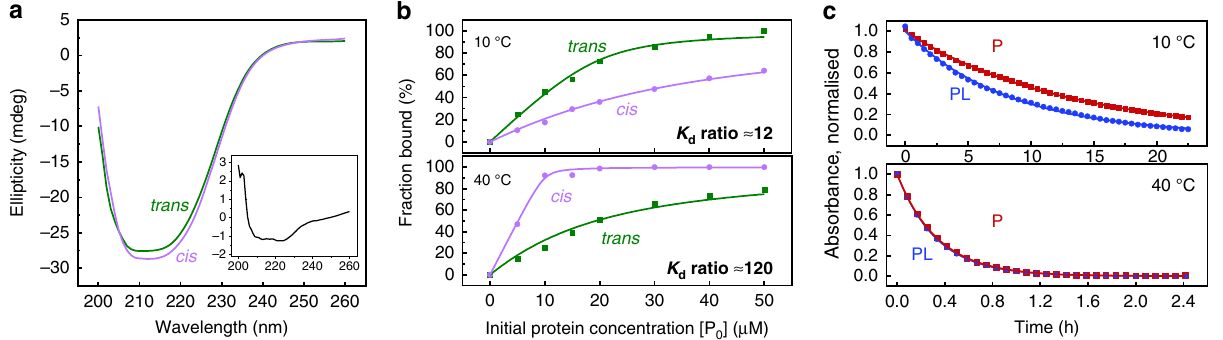
Fig. 2 Spectroscopic observables. a CD spectra of the photocontrollable PDZ3 domain in trans (green) and cis (violet), showing the difference in helicity between the two con fi gurations of the photoswitch. Inlet graph shows the trans to cis CD difference spectrum, which corresponds to the CD signal of an isolated helical protein. b Fraction of bound ligand as a function of initial protein concentration [ P 0 ] with the initial ligand concentration [ L 0 ] kept fi xed at 15 μ M. Data are shown for the photoswitch in trans (green) and cis (violet) con fi gurations and at 10°C (top) and 40°C (bottom). c Thermal cis -to- trans relaxation of the photocontrollable PDZ3 alone (red), and with saturating concentrations of the ligand (blue) at 10°C (top) and 40°C (bottom). Source data are provided as a Source Data fi le.